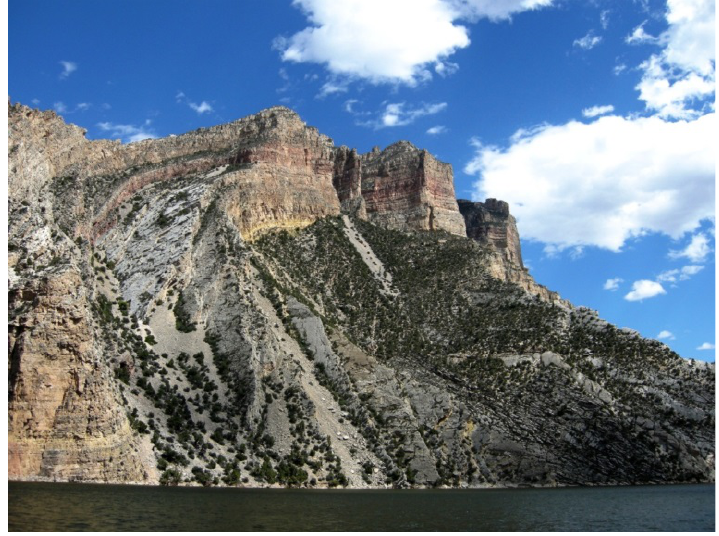
Figure 2. Northern portion of the Bighorn Mountains and the Bighorn